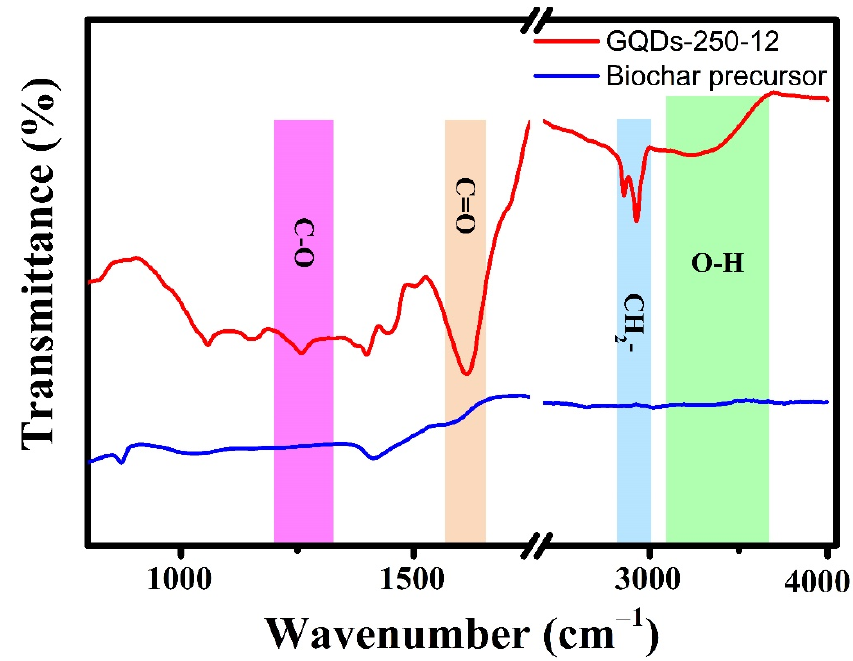
Figure 7. FTIR spectra of GQDs-250-12 and biochar precursor indicating the growth of functional groups on the surface of GQDs during synthesis.